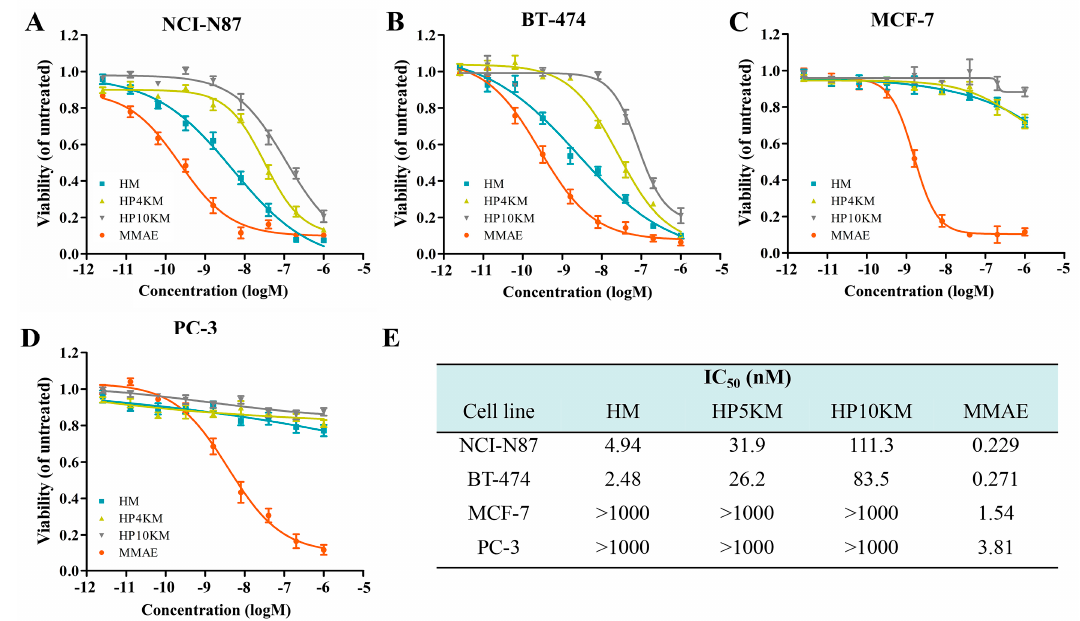
Figure 3. Cell viability determined using MTT assays. NCI-N87 cells ( A ), BT-474 cells ( B ), MCF-7 cells ( C ), and PC-3 cells ( D ) were incubated with different concentrations of HM, HP4KM, HP10KM, or MMAE for 72 h, and then, the cell viability was determined through MTT assays. ( E ) IC 50 data of the conjugates HM, HP4KM, HP10KM, and MMAE against various tumor cell lines. Data were expressed as the mean ± SEM ( n =